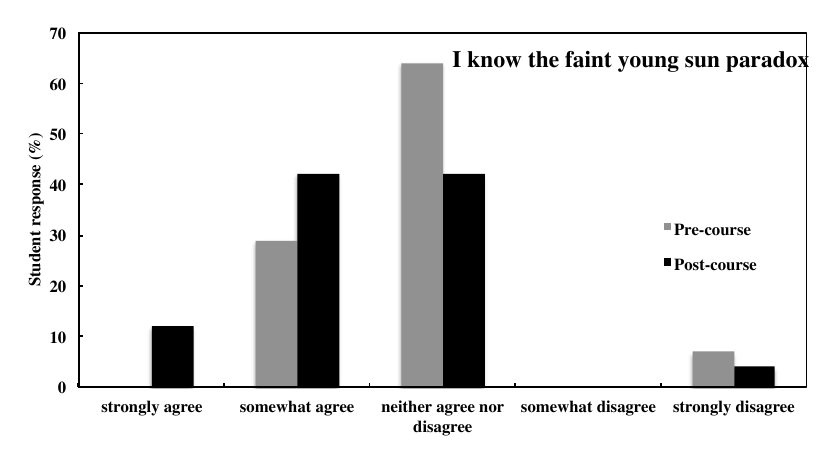
Figure 2. Understanding Darwin evolution. Figure 4. Knowing the faint young sun